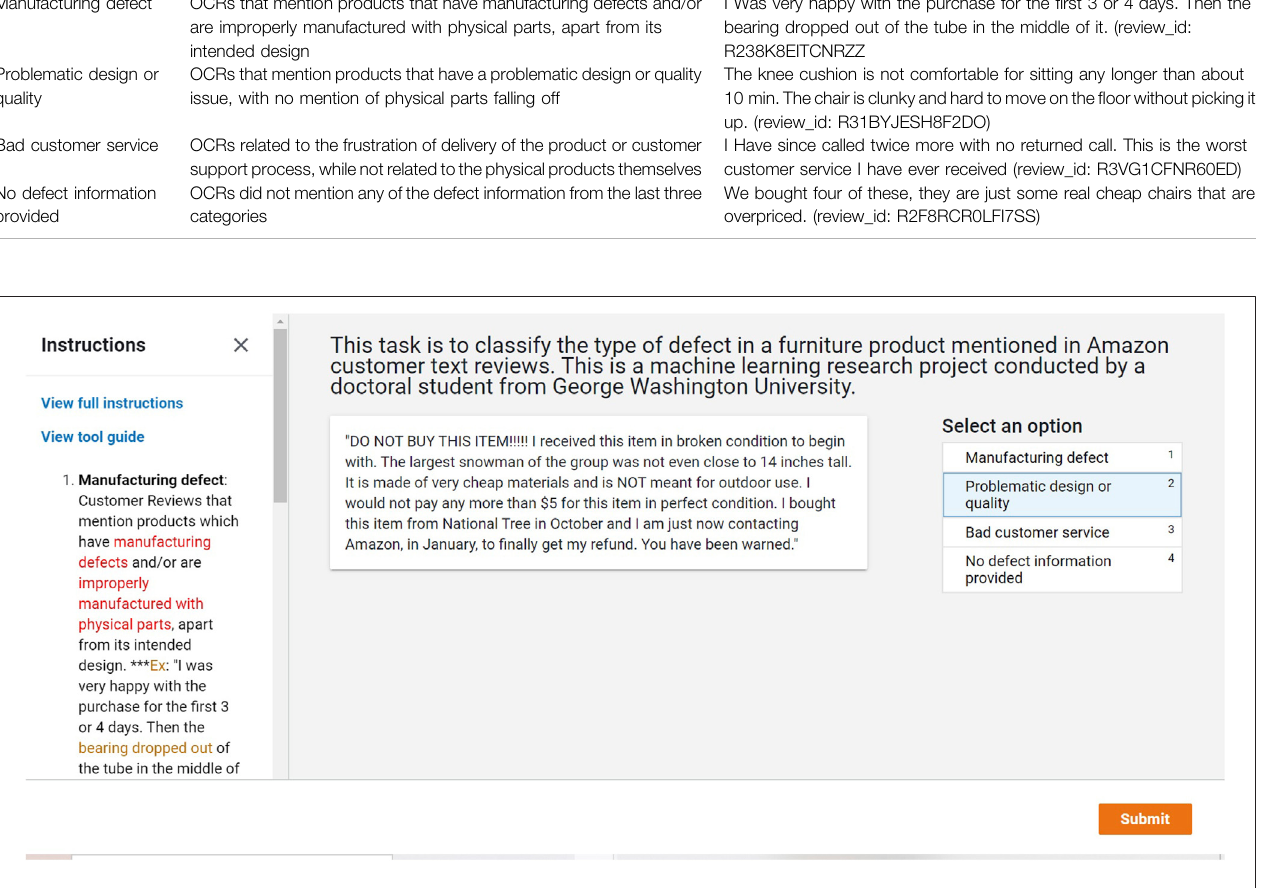
FIGURE 2 | AWS SageMaker interface for